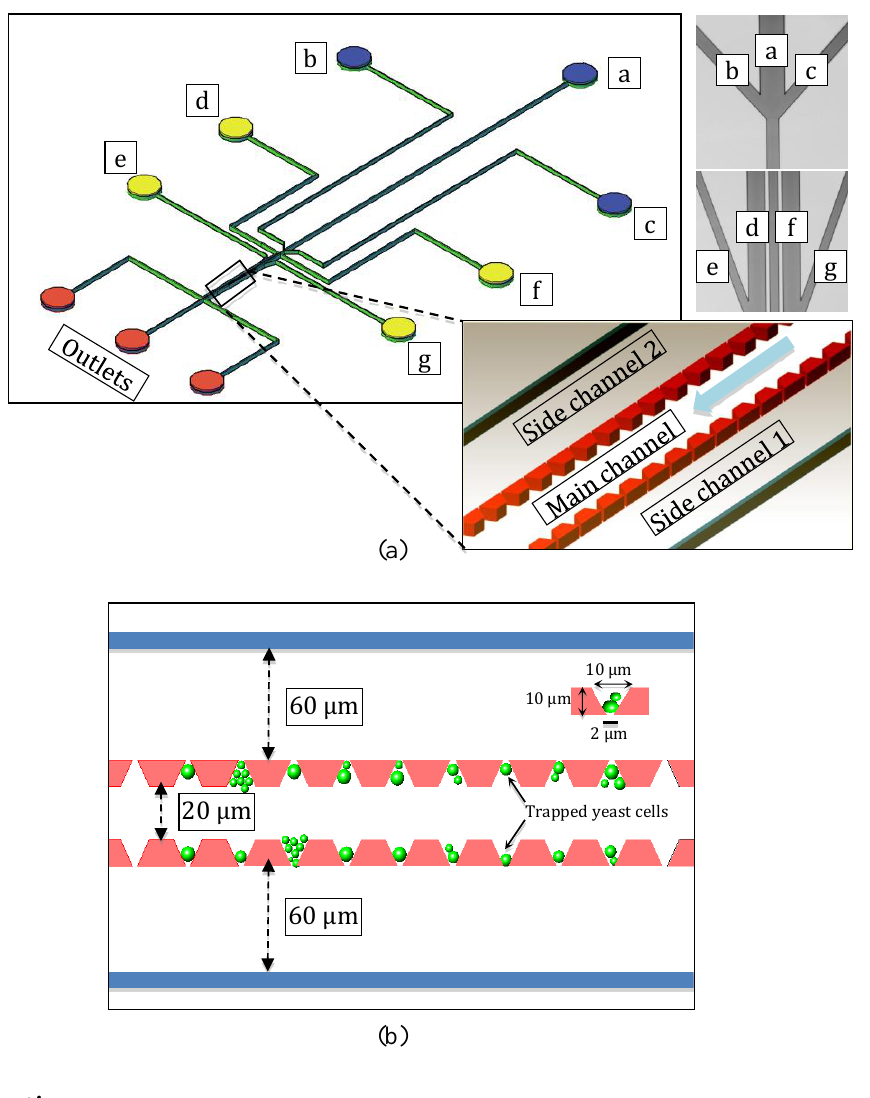
Figure 1. ( a ) Overview of the microfluidic device with inlets and outlets. Inlets “ a ”, “ b ”, and “ c ” were connected to the main channel and used to inject the cells and stress substances into the device. Inlets “ d ” and “ f ” were used as the side inlets for hydrodynamic cell loading and reagent injection into the side channels. Inlets “ e ” and “ g ” were sheath flow inlets. Close-up view shows the trapping zone of the device and the flow direction in the main channel. ( b ) Device dimensions engineered for experiments with yeast